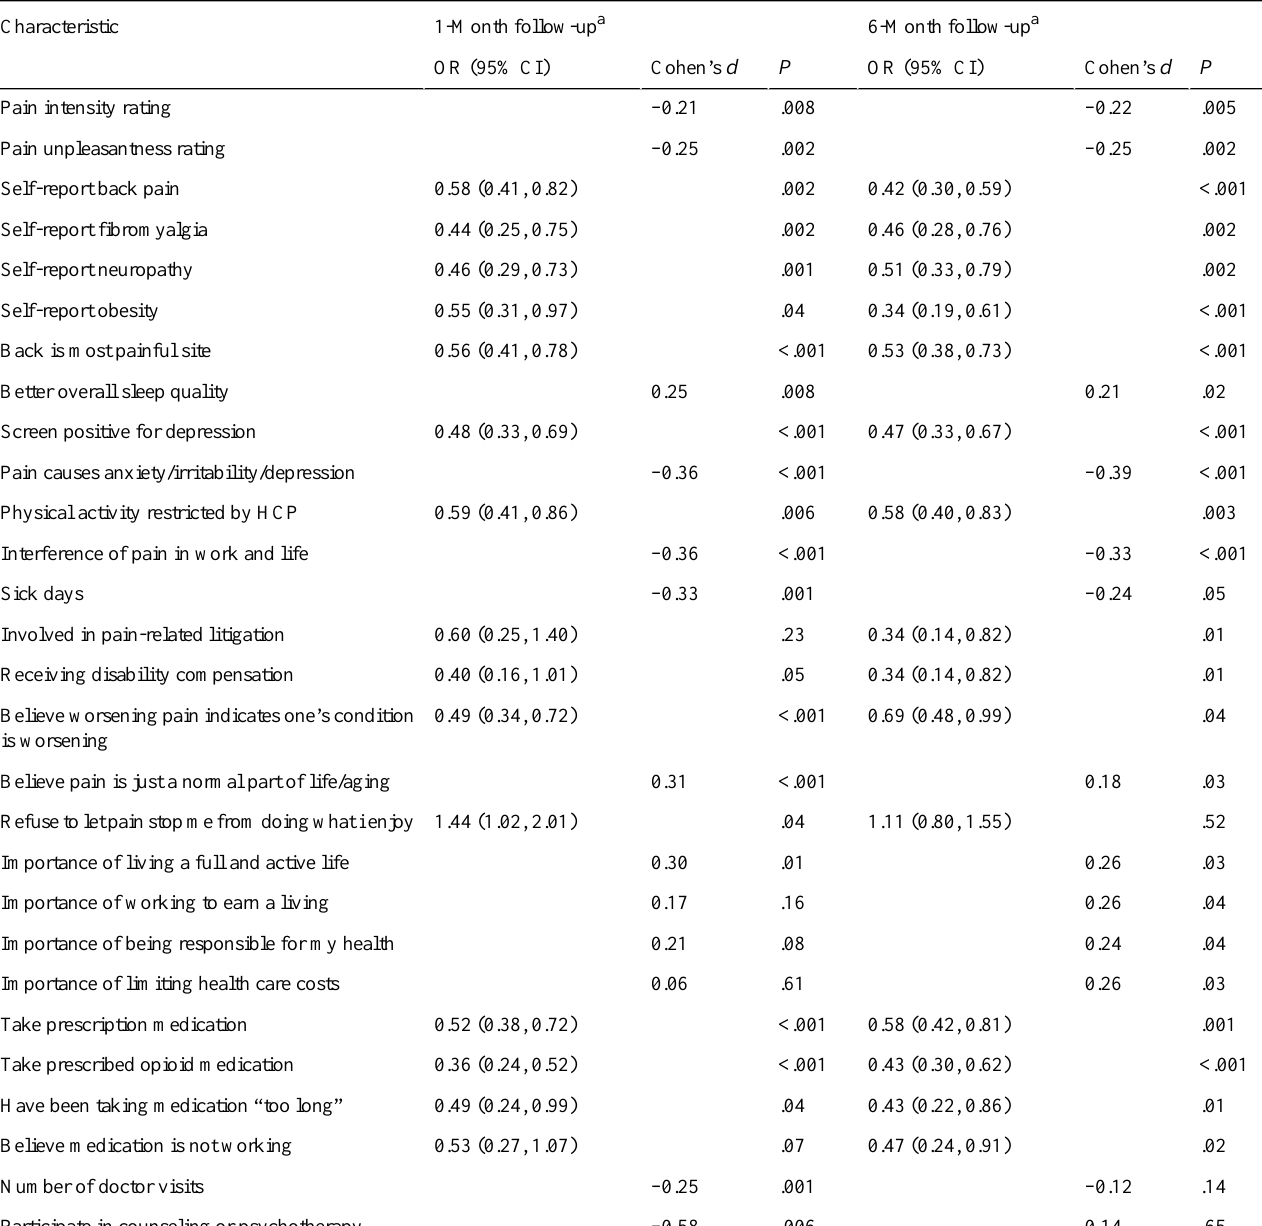
Table 3. Baseline characteristics distinguishing treatment responders from treatment nonresponders at 1 month and 6 months (N=645).